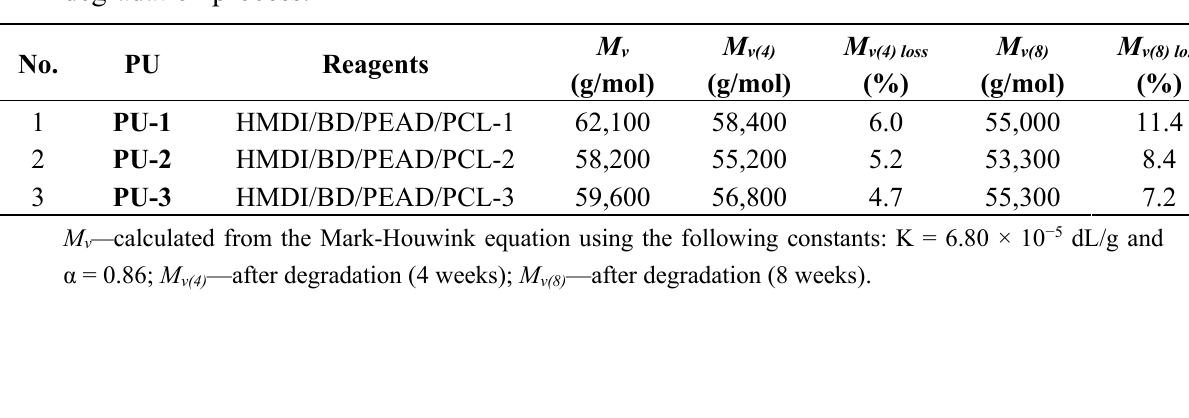
Table 4. Molecular weight-change of the obtained polyurethanes during the in vitro degradation